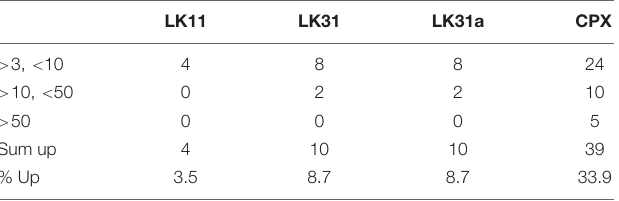
TABLE 3 | Pyoverdine inhibitors do not trigger overt host defense response. LK11